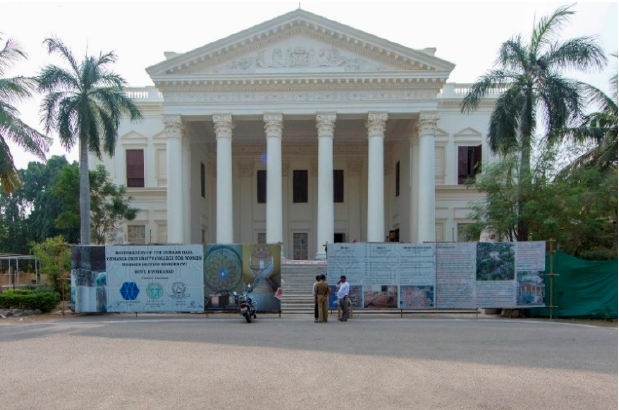
Figure 1. Northern facade of the British Residency in Hyderabad (image courtesy of the site conservation team, GN Heritage Matters).